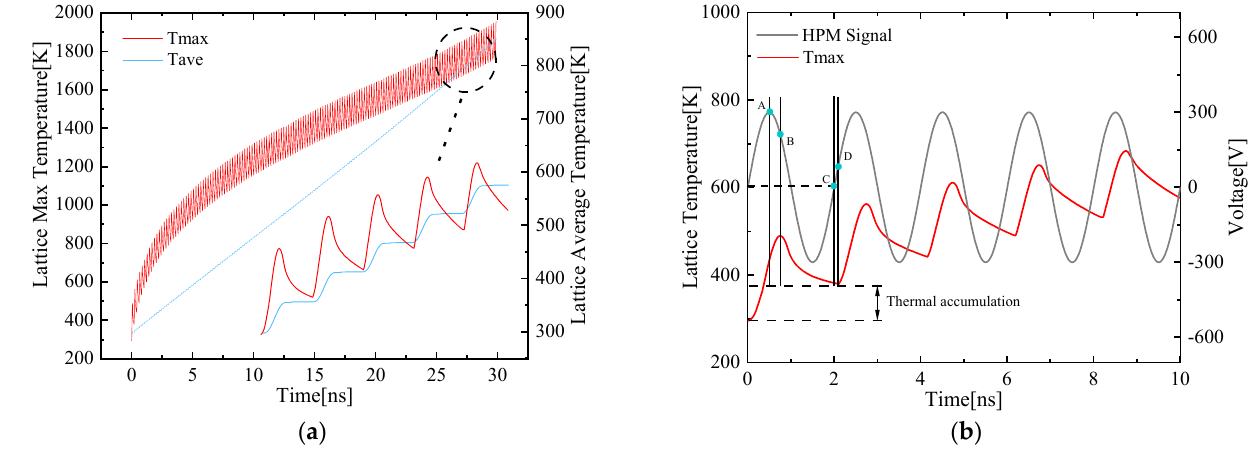
Figure 10. ( a ) Variation of Tmax (maximum temperature, red line, left Y-axis) and Tave (average temperature, blue line, right Y-axis) over time inside the device; ( b ) Tmax (red line, left Y-axis) and HPM signal (grey line, right Y-axis) change trend within 10 ns.